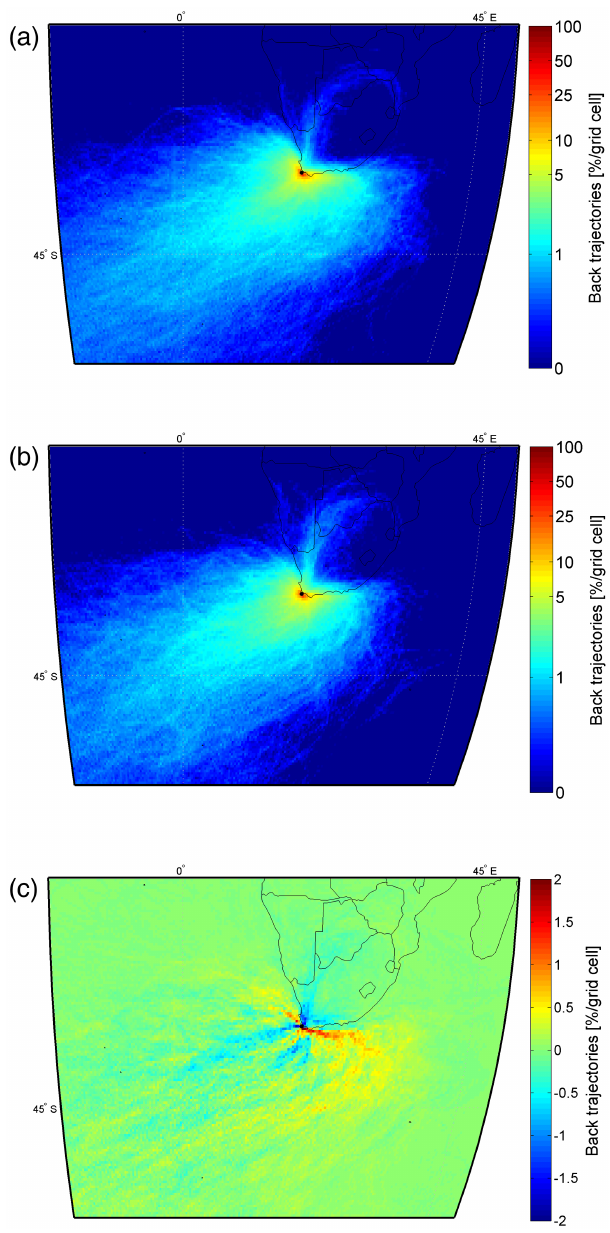
Figure 4. Normalised back trajectory analysis map, i.e. hourly arriving 8-day back trajectories with 100 m arrival height over- laid with MATLAB and normalised to percentage for the en- tire sampling period for, (a) cluster one, i.e. GEM concentra- tion > 0.904ngm − 3 , (b) for cluster two, i.e. GEM concentration < 0.904ngm − 3 and (c) the difference between the two individual maps, i.e. percentage of trajectories passing over each correlating 0.2 ◦ × 0.2 ◦ grid cells in (b) subtracted from the percentage of tra- jectories passing over each 0.2 ◦ × 0.2 ◦ grid cell in (a) . The colour bar indicates the percentage of trajectories passing over each grid